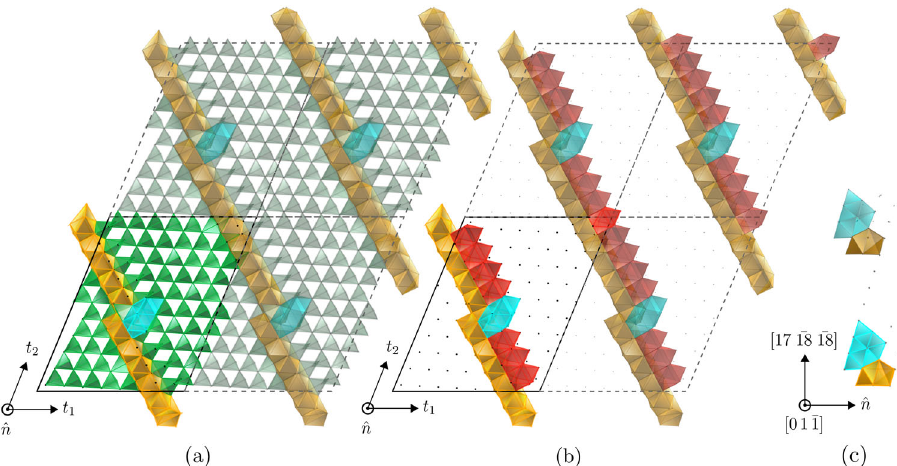
Fig. 12 The polyhedral unit model of the Σ 3(18,9,8) general GB is illustrated. a , b The atomistic structure along with the polyhedral units are shown. Two images along the same view (i.e., along the boundary-plane normal vector, ^ n ¼ ½ 18 ; 9 ; 8 (cid:5) ) are provided to simplify the ! ! presentation. The long orange units are repeated in the two views. The vectors t 1 and t 2 are along ½ 529 (cid:5) and ½ 120 (cid:5) , respectively. This GB is close in orientation to the Σ 3(111) GB, and hence, contains twin facets (represented by the green dual-tetrahedral units). The GB also has the CTP units that correspond to the polyhedral units of the Σ 3 ½ 211 (cid:5) GB. The two-dimensional unit cells of the GBs are highlighted and four unit cells are shown. The GB contains ledges and the polyhedral units that belong to these ledges are the same as those observed in the Σ 3 ð 945 Þ . The blue polyhedral unit has the same structure as shown in Fig. 11 with fi fteen atoms. The long polyhedral unit (shown in orange) is an extension of the orange polyhedral unit shown in Fig. 11. The polyhedral units of the ledge are emphasized in c by viewing the GB along the ½ 011 (cid:5)